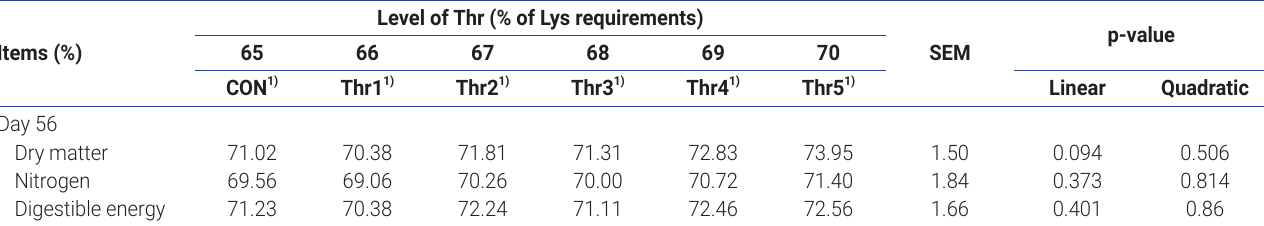
Digestible energy